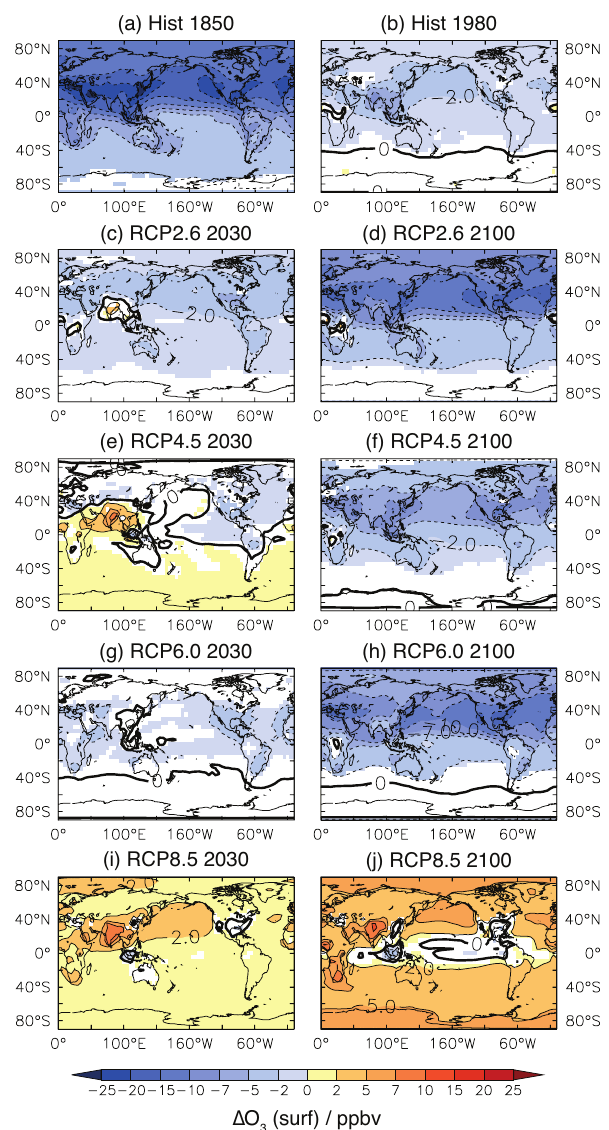
Fig. 11. As Fig. 9, but for the absolute change in surface ozone